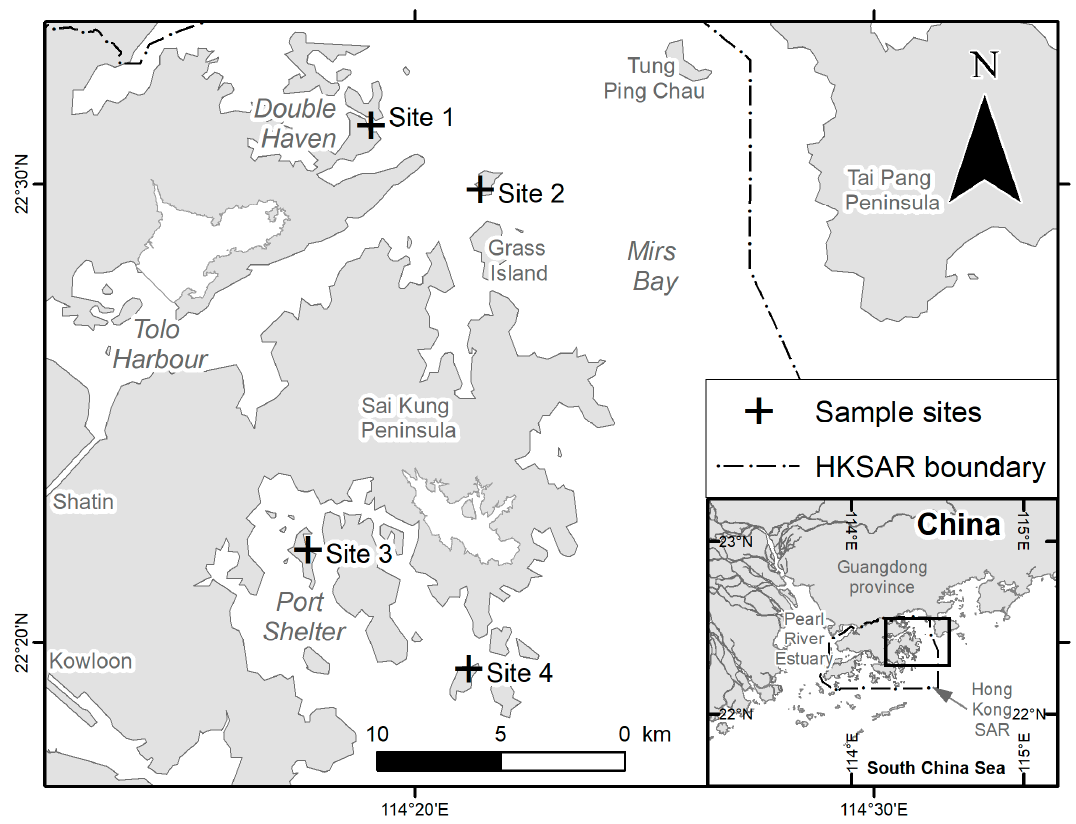
Figure 1. Map of four sample sites of this study. Site 1: Double Island; Site 2: Port Island; Site 3: Sharp Island; Site 4: Bluff Island.